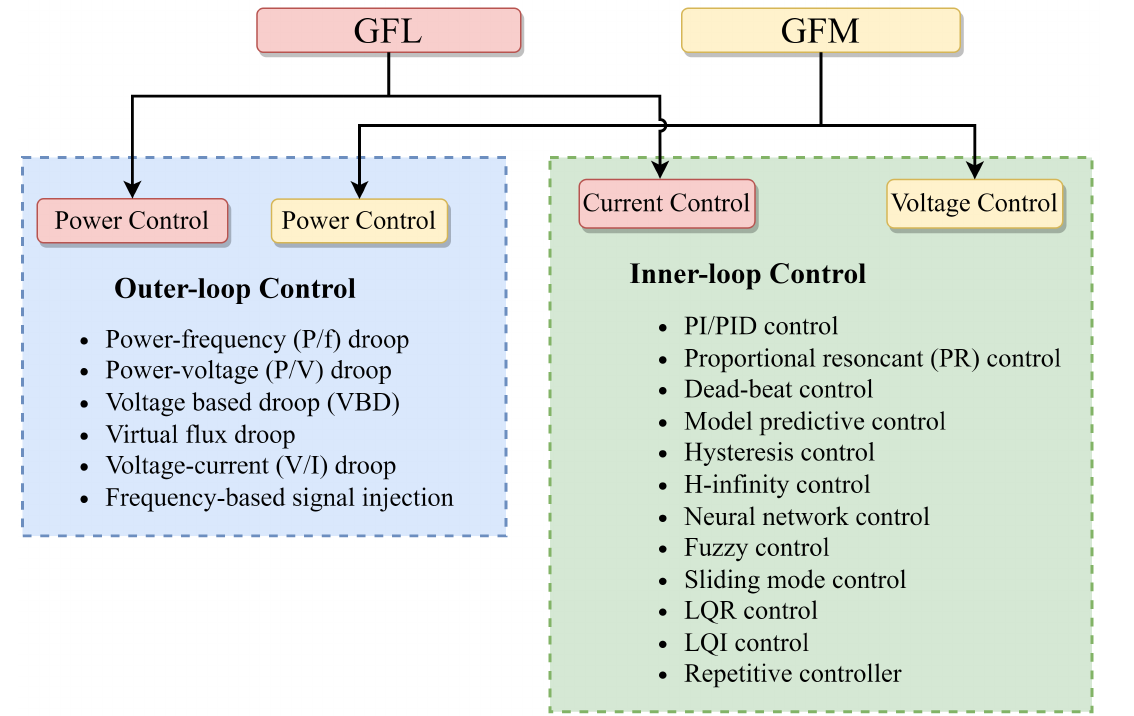
Figure 5. Control techniques for outer and inner control loops